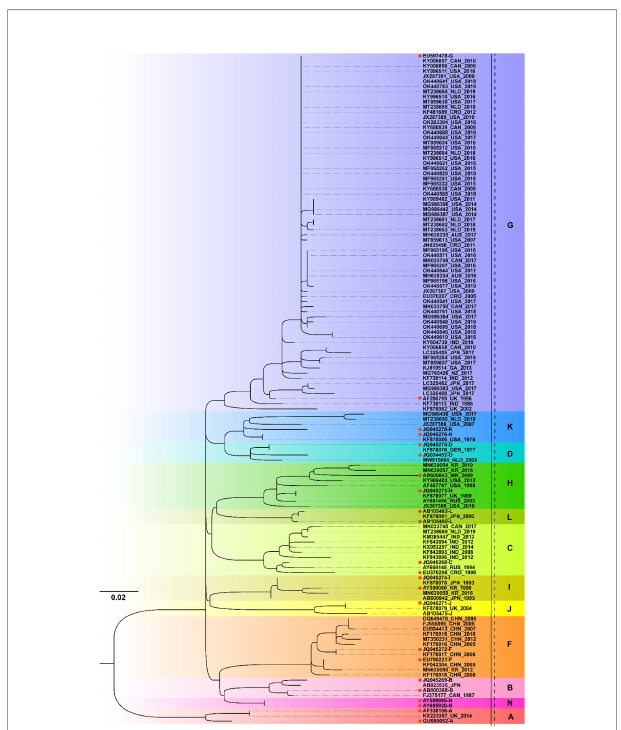
FIGURE 2 | Phylogenetic analysis of mumps strains circulated worldwide based on 316 nucleotides of the SH gene, with reference strains of 12 genotypes (A, B, C, D, F, G, H, I, J, K, L, and N). The nucleotide substitution model used for the phylogenetic tree was TVM+F+G4, and the bootstrap value was set to 2000. (cid:129) marks the reference sequences of the 12 genotypes; AUS, Australia; CAN, Canada; CHN, China; CRO, Croatia; GER, Germany; GA, Gabon; IND, India; JPN, Japan; KR, Republic of Korea; MN, Mongolia; NLD, Netherlands; NZ, New Zealand; RUS, Russia; UK, United Kingdom; USA, United States.